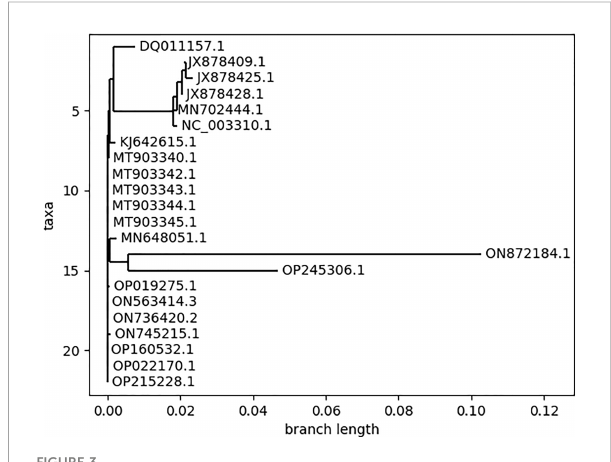
FIGURE 3 Phylogenetic tree of 22 monkeypox virus strains constructed using the respective